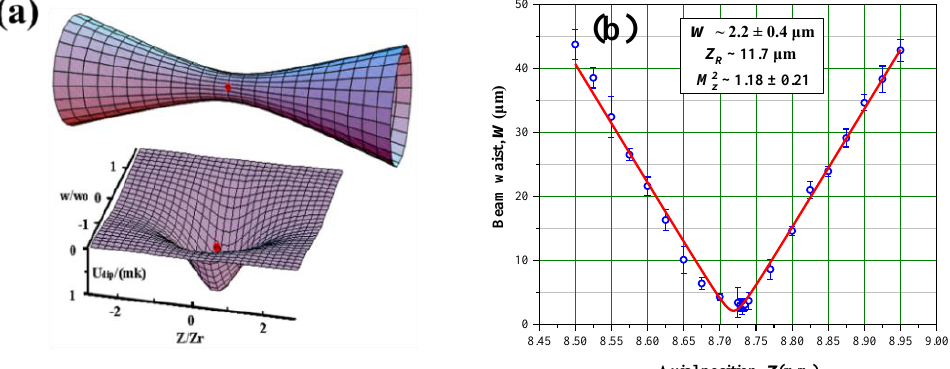
Figure 4. Scheme of optical tweezer. ( a ) A strongly focused single-spatial mode Gaussian beam of a red-detuned laser can confine atoms. ( b ) The beam waist radius and Rayleigh length of 1064-nm optical tweezer are 2.2 μm and 11.7 μm, respectively.